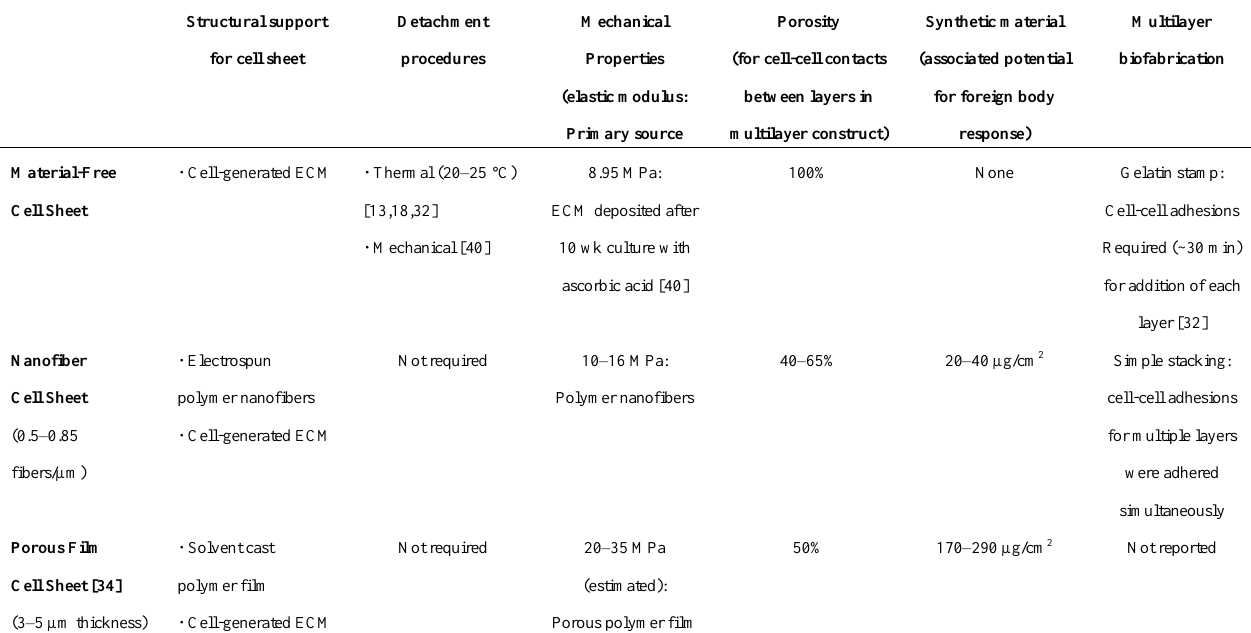
Table 1. A comparison among three methods in cell sheet engineering, i.e. , material-free cell sheets, composite nanofiber/cell sheets and a porous polymer film-based cell sheet in terms of five properties pertaining to tissue engineering